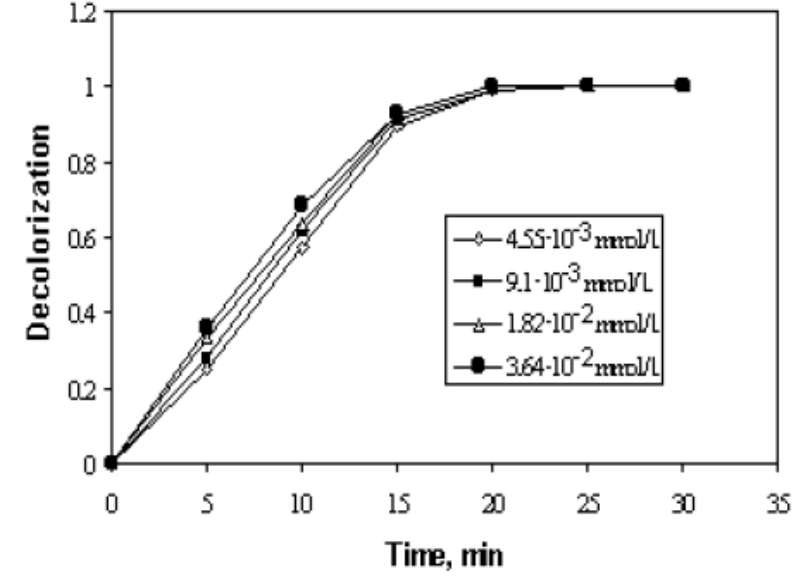
Fig. 16 Effect of Mn 2+ ions on AOP in acidic medium. Initial conditions: C dye =50 mg/L, [H 2 O 2 ]= 17.318